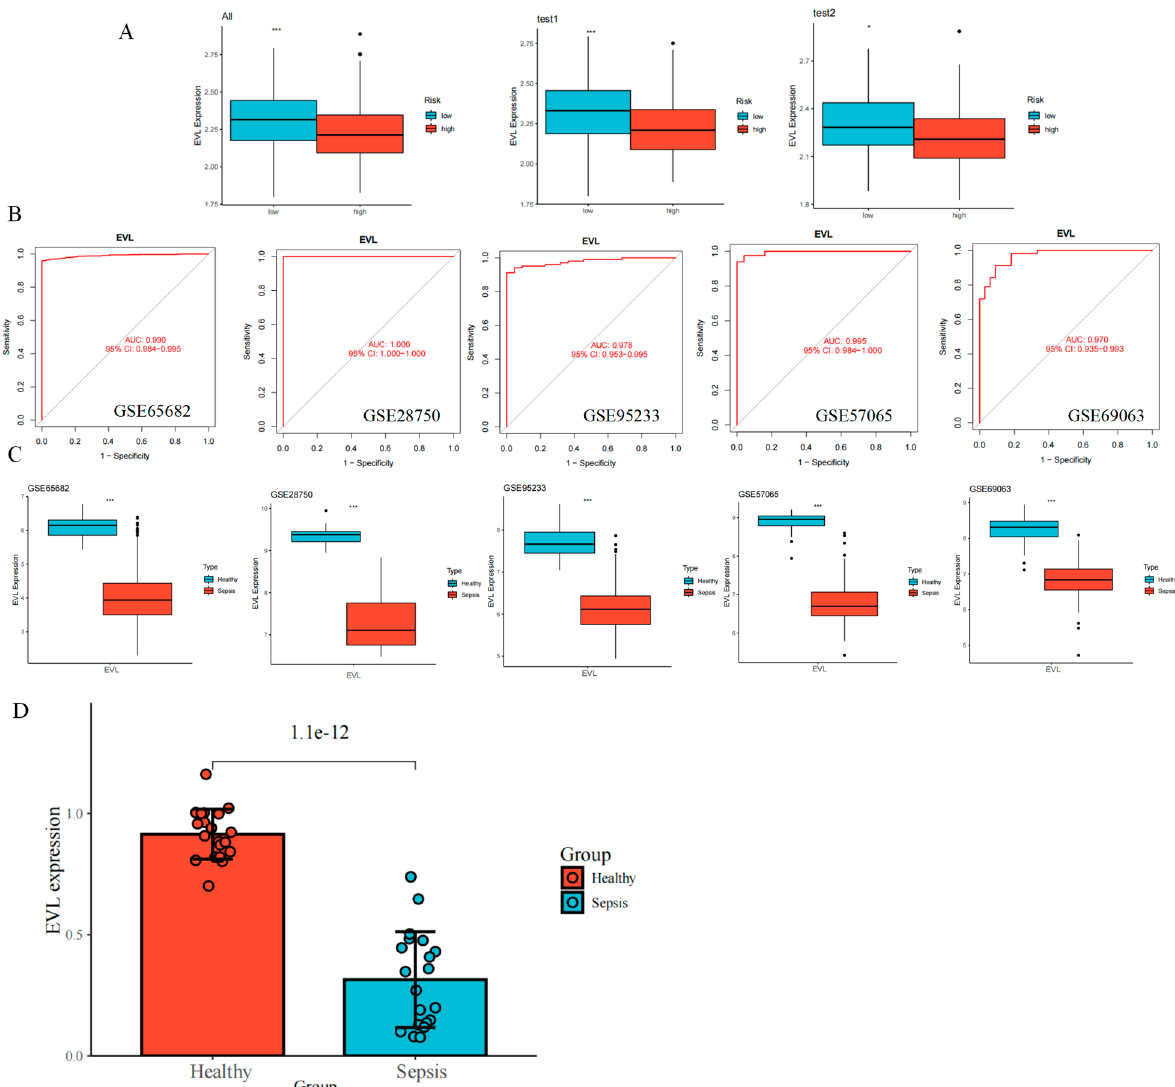
Fig. 5 Analysis of the diagnostic and prognostic value of EVL . A Expression of EVL in high-risk and low-risk patients. Low-risk patients in blue and high-risk patients in red; B ROC curves of EVL in different datasets; C Differential expression of EVL among healthy patients with any sepsis. Blue is for healthy people and red is for sepsis patients; D Clinical sample validation of EVL differential expression in healthy individuals and sepsis patients. Red for healthy people and blue for septic patients. *P < 0.05, **P < 0.01, ***P < 0.001, ****P < 0.0001 by two-tailed